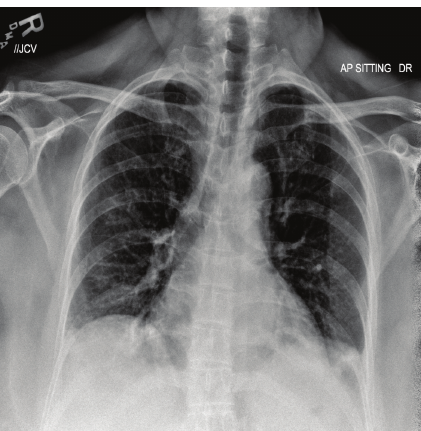
Figure 3: MRI of spine showing intramedullary demyelination in the spinal cord, evident as enhanced T2 signal, with peripheral contrast enhancement, extending from C2 to T1 vertebral body